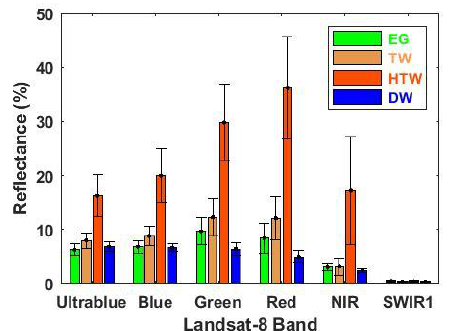
Figure 3. Mean reflectance values for each class for the first 6 Landsat-8 bands for both images Table 3. The confusion matrix assessing the out-of-bag training areas within the classifier was combined for both images and is presented in Table 5. The classification accuracy is high, with an overall accuracy of 99.3%. The classified image is shown in Figure 7. Detailed maps were created at a resolution of 1:250,000 around each of the main Cree coastal communities: Chisasibi (Figure 8), Wemindji (Figure 9), Eastmain (Figure 10), and Waskaganish, (Figure 11).